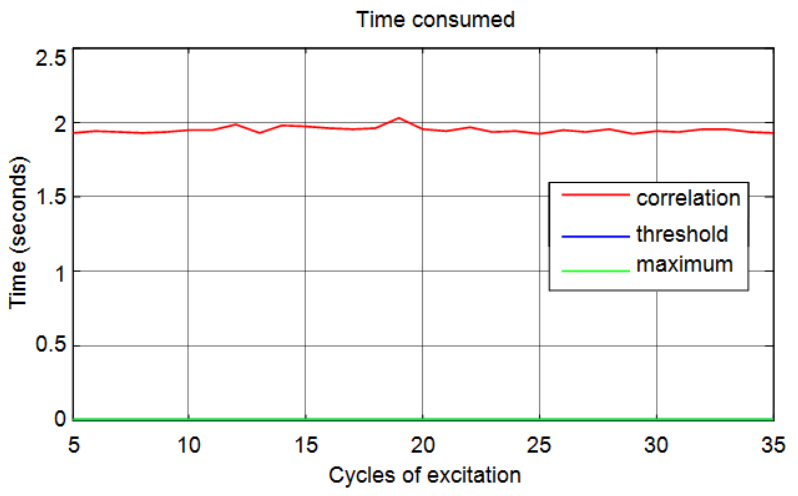
Figure 18. Computation time for the calculation of